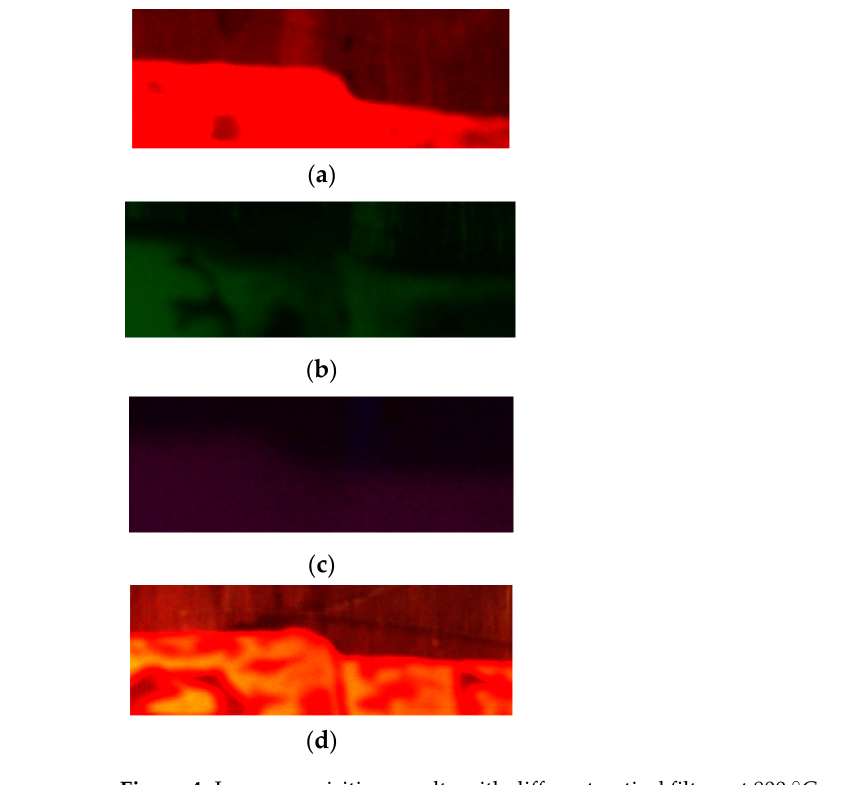
Figure 4. Image acquisition results with different optical filters at 800 °C without light. ( a ) Red optical filter; ( b ) Green optical filter; ( c ) Blue optical filter; ( d ) Infrared optical filter.